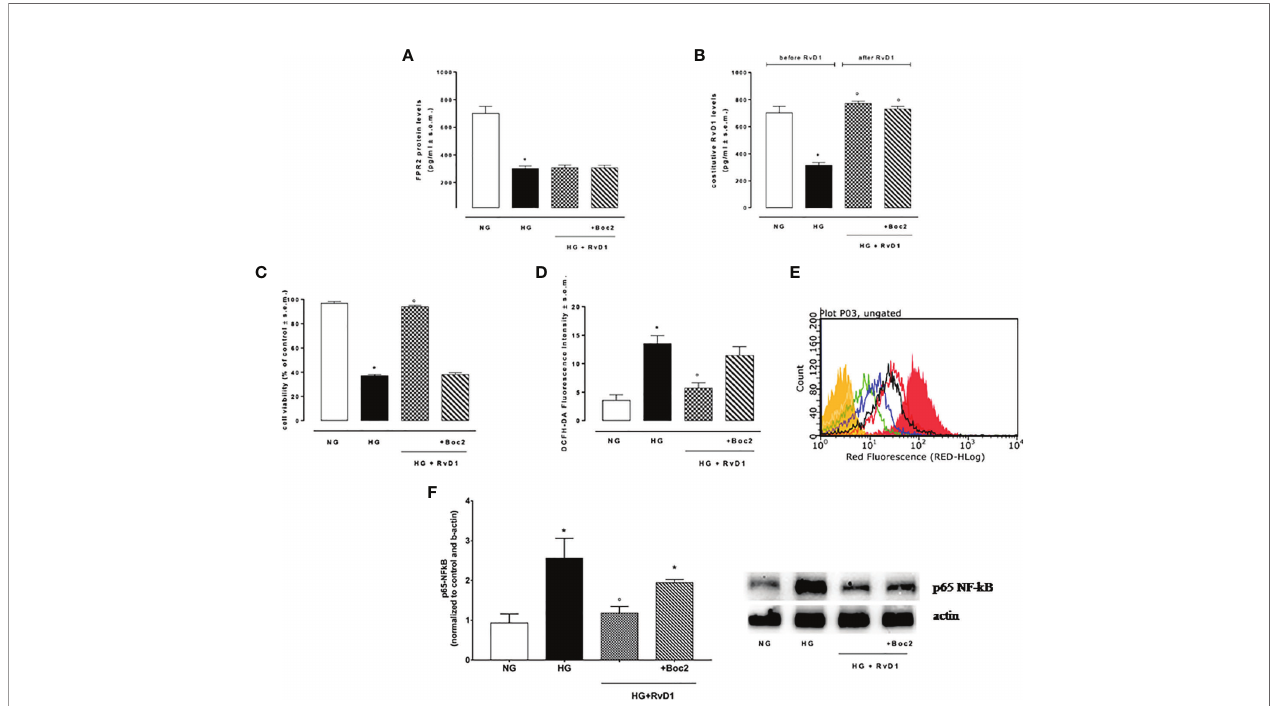
FIGURE 2 | FPR2 and RvD1 levels, cell viability, ROS content, NF-kb protein expression. (A) ELISA detecting the levels of FPR2 receptor and (B) constitutive Resolvin D1 before and after RvD1 addition to photoreceptors exposed to high glucose; (C) XTT assay for determination of total cell number; (D, E) average intensity from DCFH-DA for total intracellular ROS levels compared to a negative control (yellow) and a positive control ( fi ll red, 100 m M H2O2). Green = normal glucose; black = high glucose; blue = HG + RvD1 and red = HG + RvD1 + Boc2; (F) Western Blotting determination and representative images of NF k B protein levels into photoreceptors stimulated with normal glucose (5 mM D-glucose); high glucose (30 mM D-glucose); HG + RvD1 (RvD1, 50 nM); HG + RvD1 + Boc2 (20 m M). Values are expressed as mean ± s.e.m. of n = 9 values, obtained from the triplicates of three independent experiments. They were analyzed by one-way ANOVA followed by Bonferroni ’ s test for each panel, except for panel (B) were ANOVA for repeated measures was applied. NG, normal glucose; HG, high glucose; RvD1, Resolvin D1; Boc-2, selective FPR2 inhibitor. *P > 0.01 vs. NG; °P > 0.01 vs. HG.